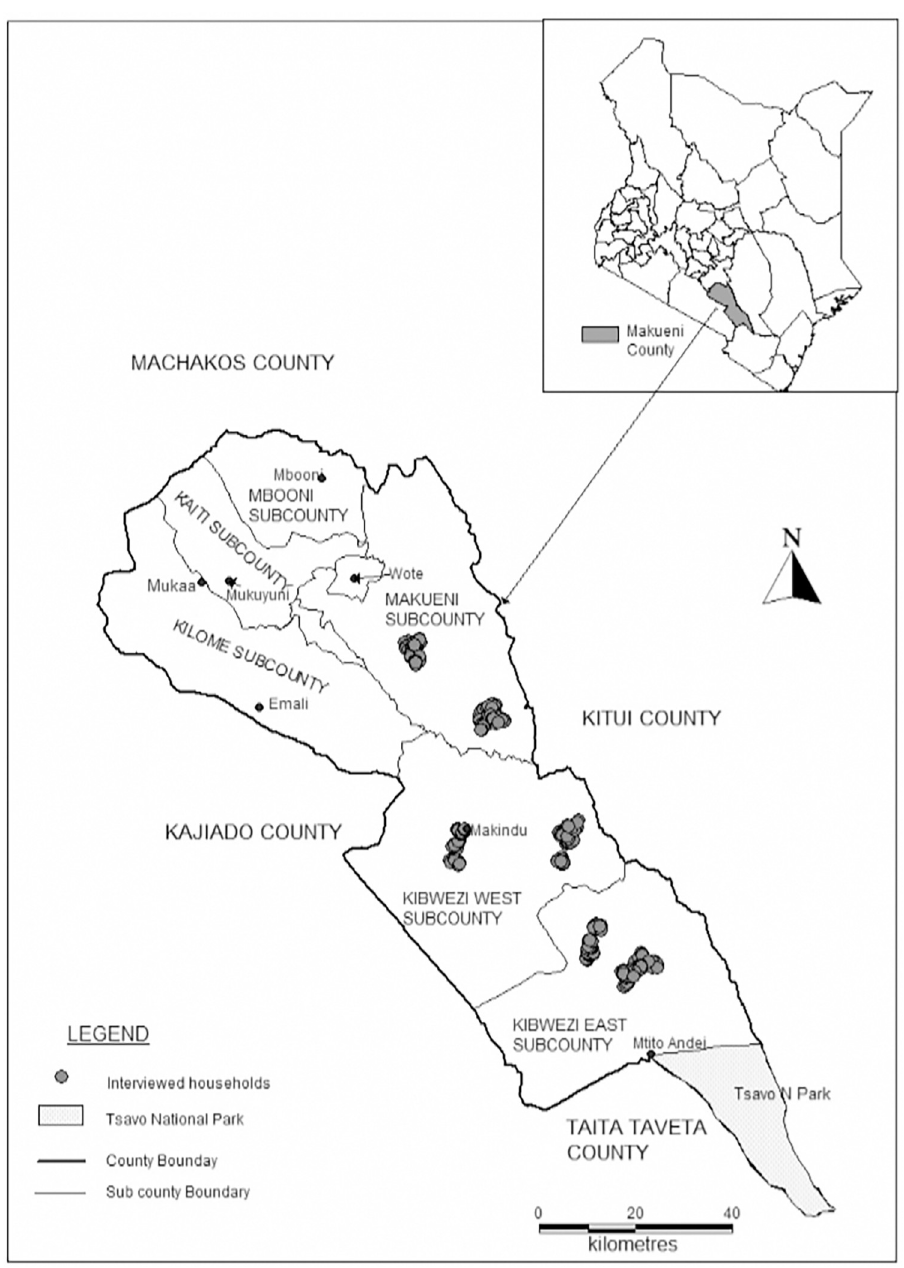
Fig 1. A map of the study area and households interviewed (made with Natural